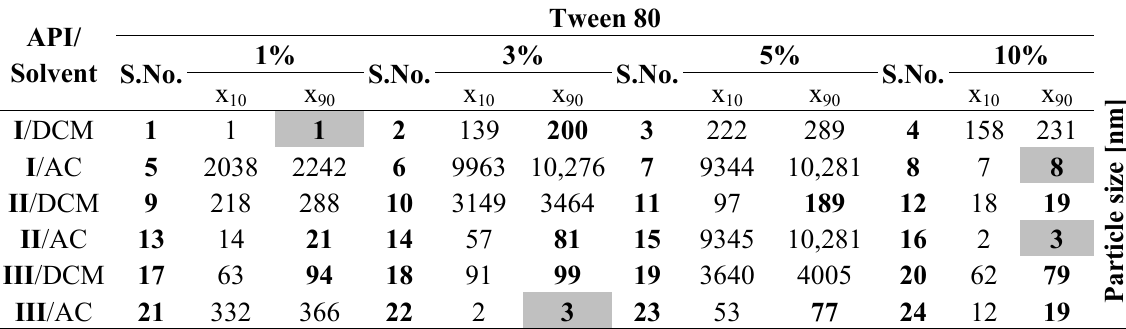
Table 1. Particle size (x , x [nm]) of APIs I – III and concentration [%] of Tween 80 in 10 90 dichloromethane (DCM) or acetone (AC). All the presented results are reported as medium value of four independent measurements, repeatability was up to 6%. Samples that contained nanoparticles <200 nm are bolded; nanoparticles <10 nm are indicated by grey background. (S.No. = sample number).